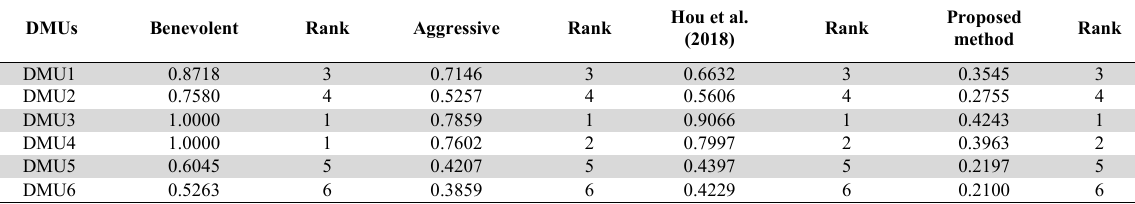
The ranking of each DMU for the methods of rice weevil disinfestations